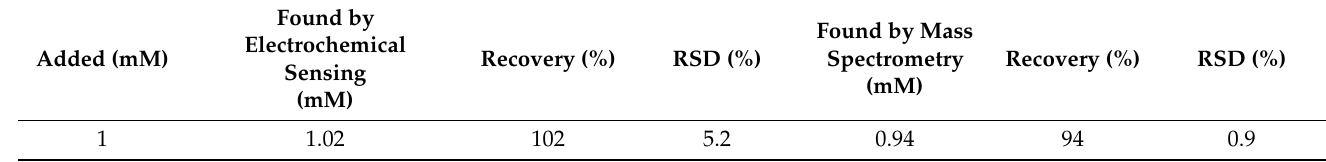
Table 6. The results of the recovery tests obtained by the electrochemical sensing and the mass spectrometric methods for